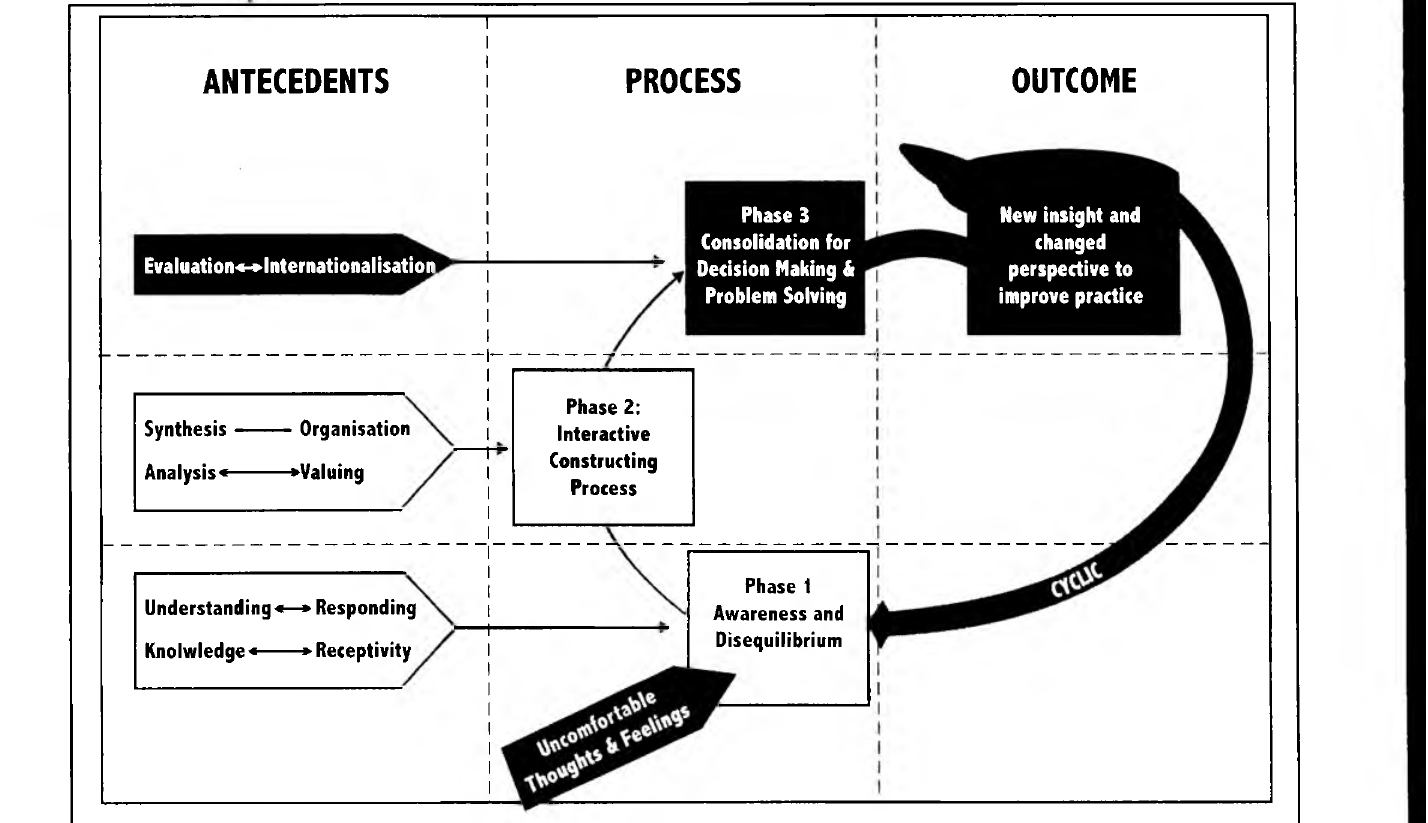
Figure 1: P hases of reflective think ng in relation to cognitive and affective thinking skills as